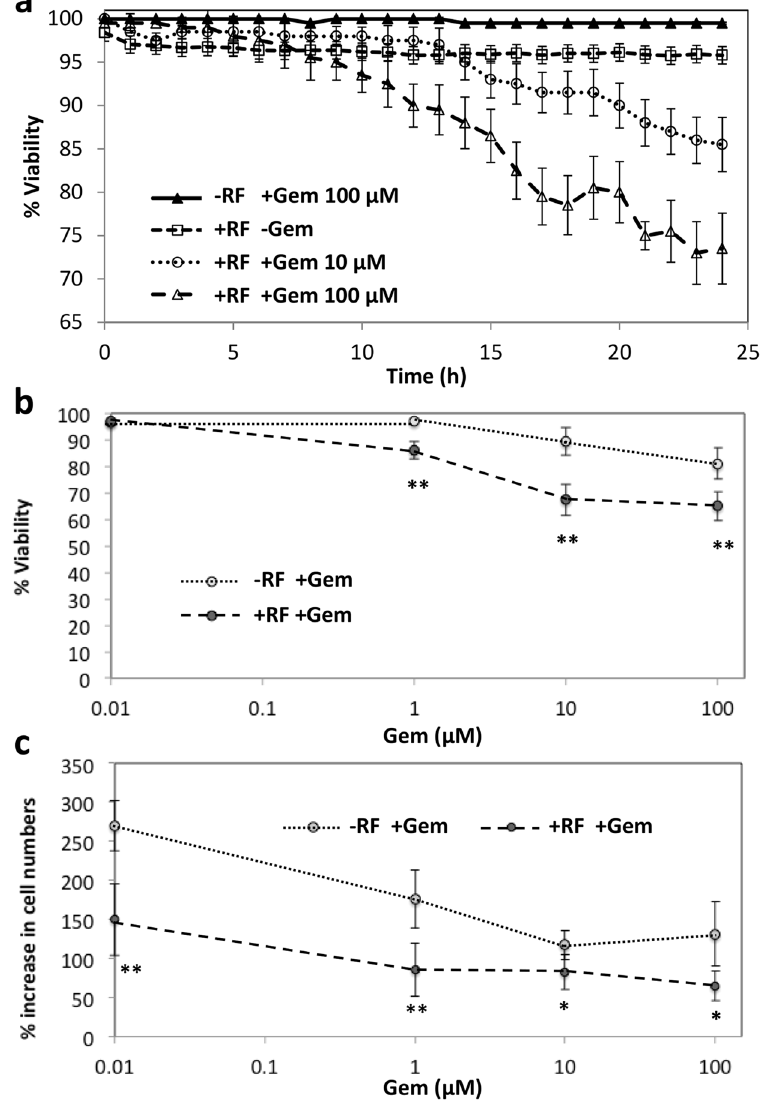
Figure 1. Combination treatment with Gem and non-invasive RF field exposure yields mildly enhanced cytotoxicity and cytostaticity as compared to Gem alone in PDAC monolayer cell culture. ( a ) Percent viability of PANC-1 cells treated with various combinations of RF and Gem; ( b ) Percent viability of PANC-1 cells treated with Gem alone and Gem + RF at 48 h; ( c ) Percent cytostaticity of PANC-1 cells treated with Gem alone and Gem + RF at 48 h. In all cases Gem was administered immediately after RF exposure (mean ± SD, n = 6). Statistical significance determined using two-tailed Student’s t-test with significance level 0.05 ( * ) or 0.01 ( **